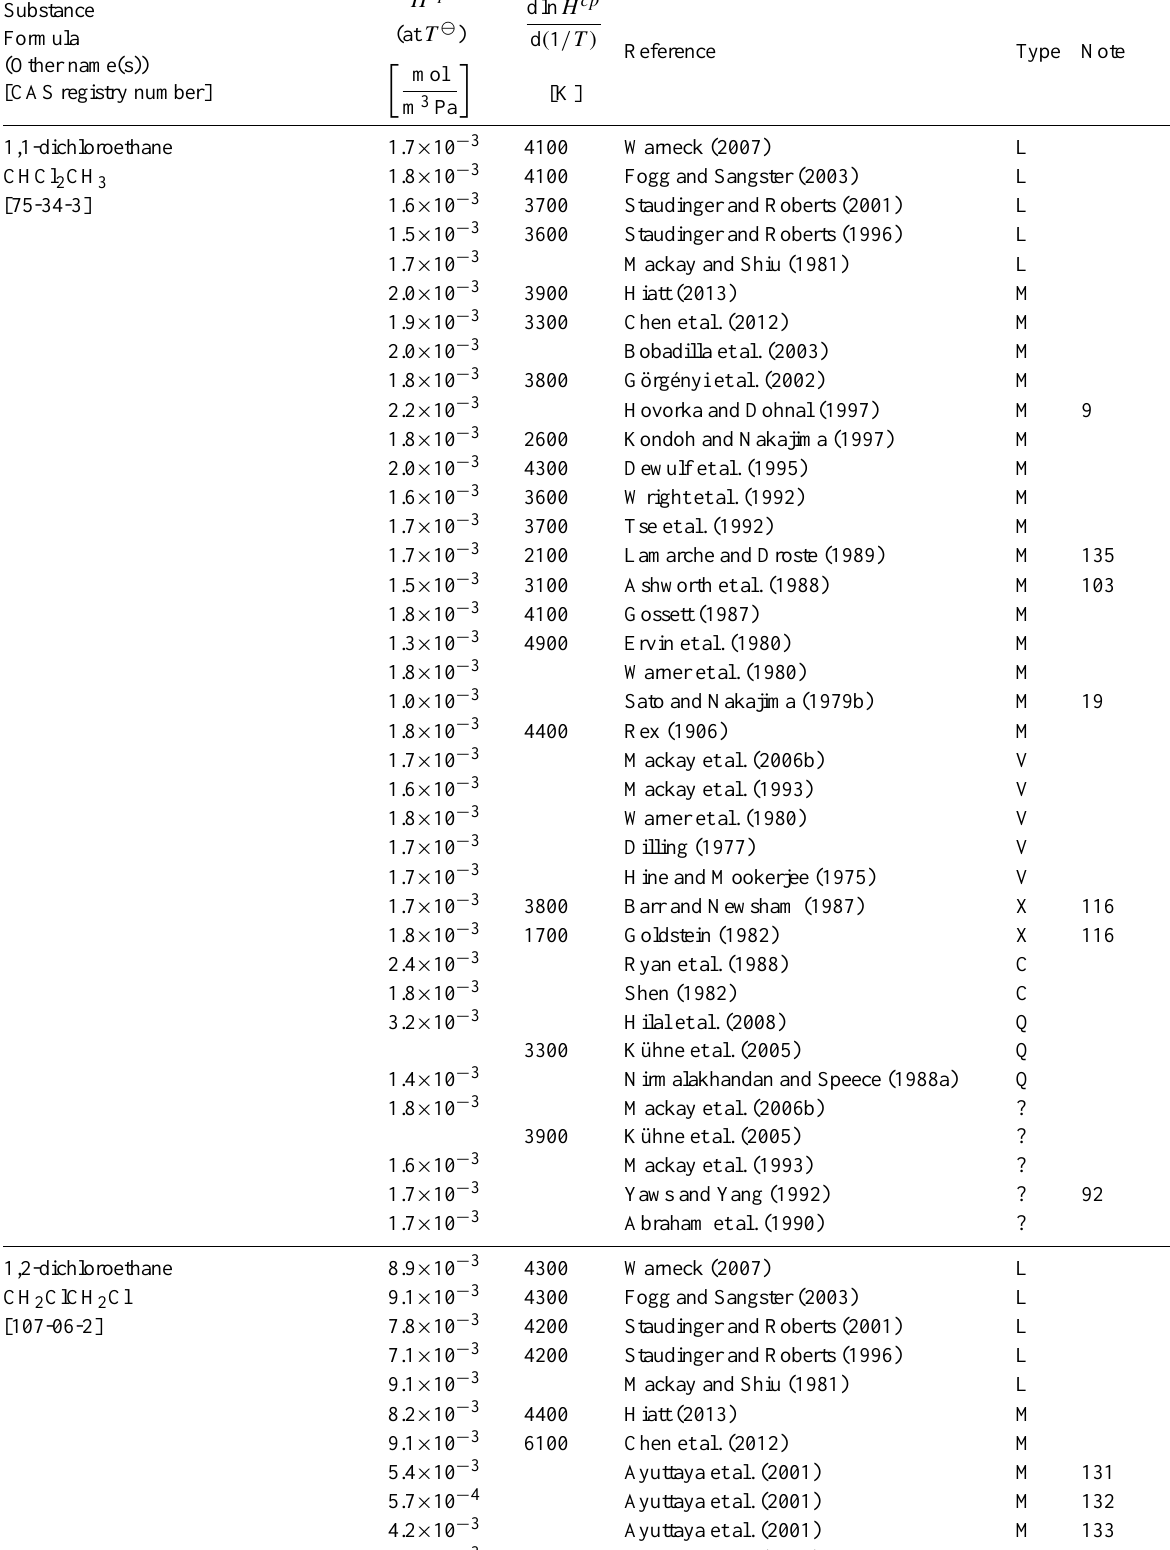
Table 6: Henry’s law constants for water as solvent